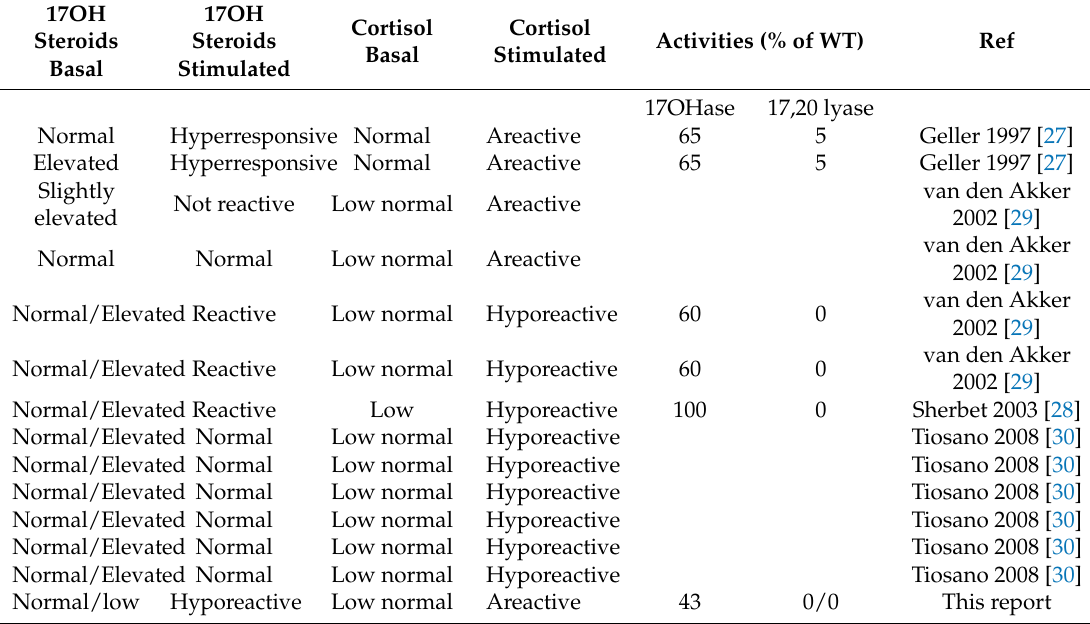
Table 1. Reported cases of CYP17A1 mutations causing isolated 17,20 lyase deficiency [27–30]. The mutation E305G which was initially reported by Sherbet et al. [28] to cause isolated 17,20 lyase deficiency, was later reported by Tiosano et al. [30] to also result in combined 17 α -hydroxylase/17,20 lyase deficiency, similar to other common mutations in CYP17A1